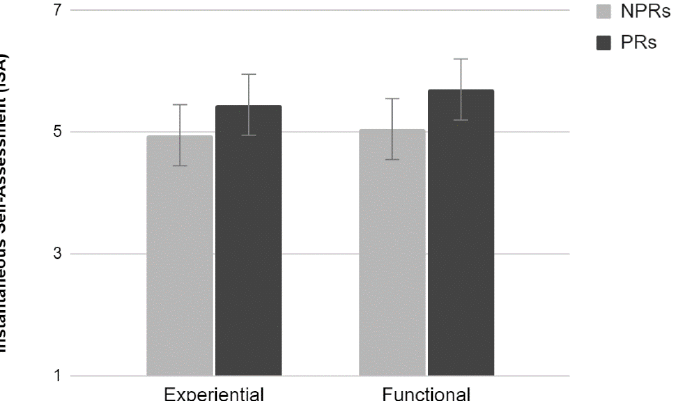
Figure 13. ISA scale score by Experience (NPRs vs. PRs) and Test (Experiential vs. Functional). Error bars denote 0.95 confidence intervals.